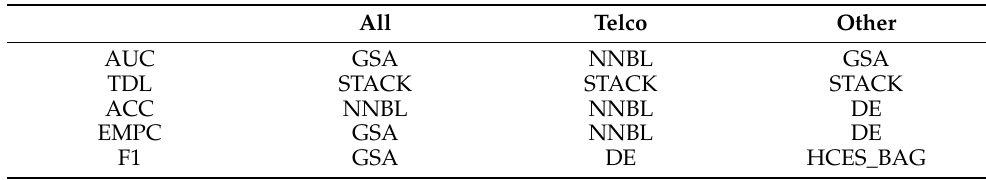
Table 8. Highest ranked classifiers for each performance measure and sectors (i.e., all, telecommuni- cations, and other remaining data